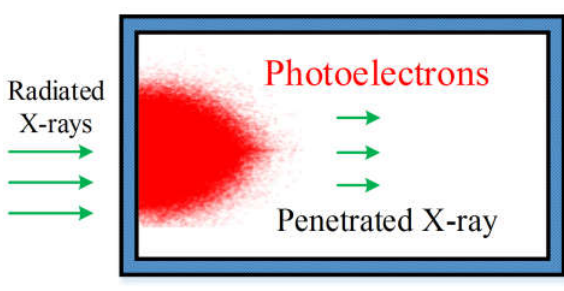
Figure 1. Simplified SGEMP model under X-ray irradiation.